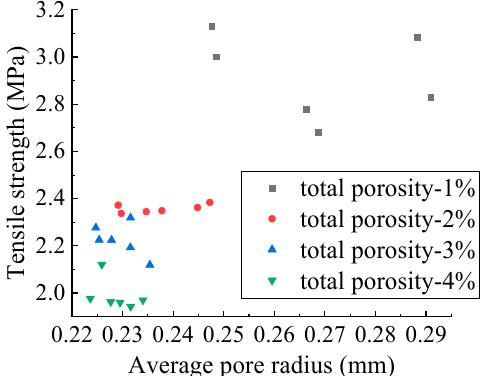
Figure 22. Relationship between average pore size and tensile strength.